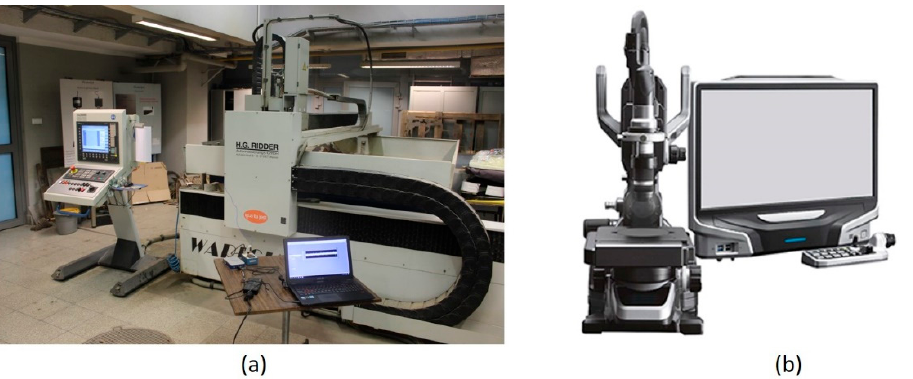
Figure 2. ( a ) H.G. RIDDER AWJ center model HWE-1520 and ( b ) Keyence 3D optical microscope.